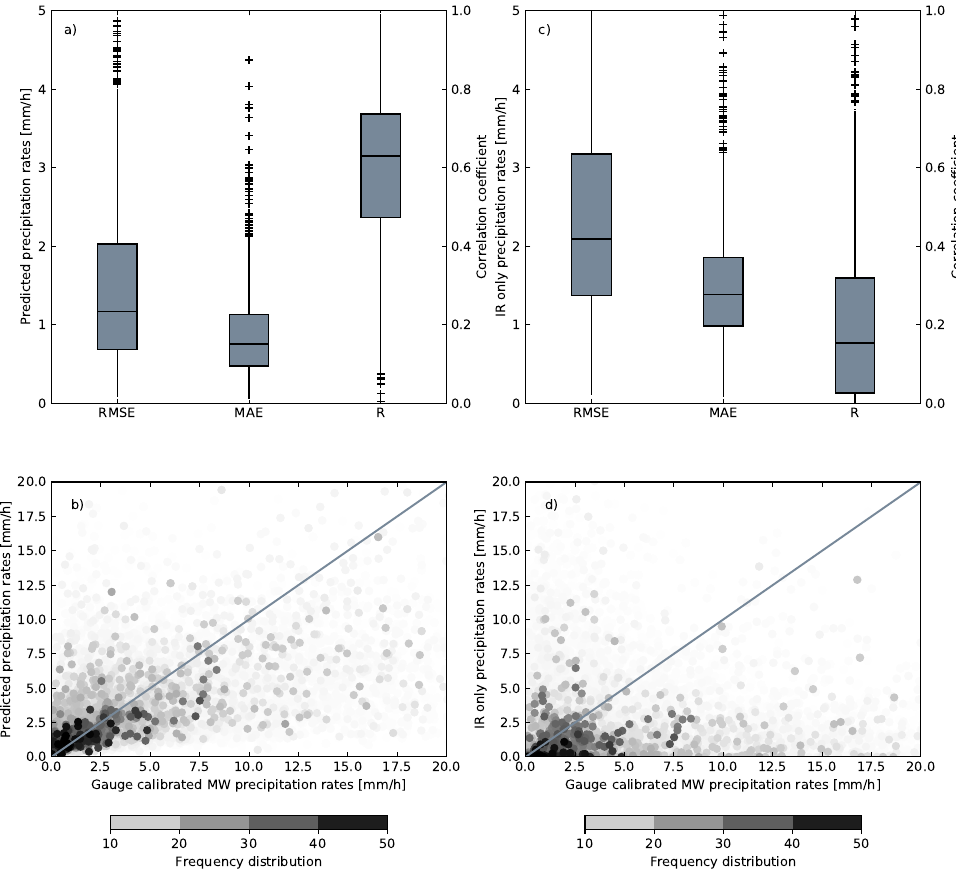
Figure 8. ( a ) Validation measures RMSE, MAE, and correlation coefficient R for the predicted precipitation rates based on the gauge calibrated MW precipitation rates from IMERG (independent validation data set: 20% of precipitating pixels from each scene). ( b ) Scatter plot between gauge calibrated MW precipitation rates and predicted precipitation rates [mm/h] with the frequency distribution of the validation pixels. ( c ) Validation measures RMSE, MAE and correlation coefficient R for the IR only precipitation rates compared to the gauge calibrated MW precipitation rates from IMERG. The boxes display the percentiles (25th, 50th, and 75th). The whiskers indicate extreme data up to 1.5 times of the interquartile range. Crosses mark outliers. The width of the boxes is relative to the number of validation scenes. ( d ) Scatterplot between gauge calibrated MW precipitation rates and IR only precipitation rates [mm/h] with the frequency distribution of the validation